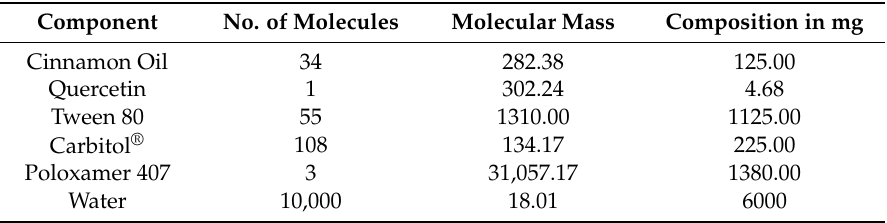
Table 7. Chemical composition of the formulation in MD